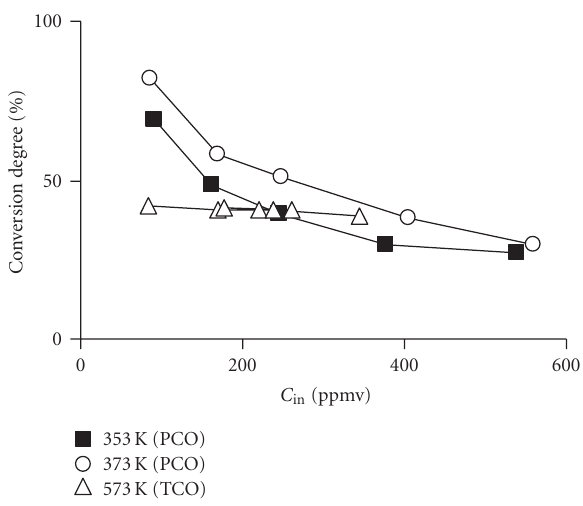
Figure 5: PCO and TCO conversion of MA versus inlet concentra- tions at ( (cid:2) ) 353 (PCO), ( (cid:2) ) 373 (PCO), and ( Δ ) 573 K (TCO).